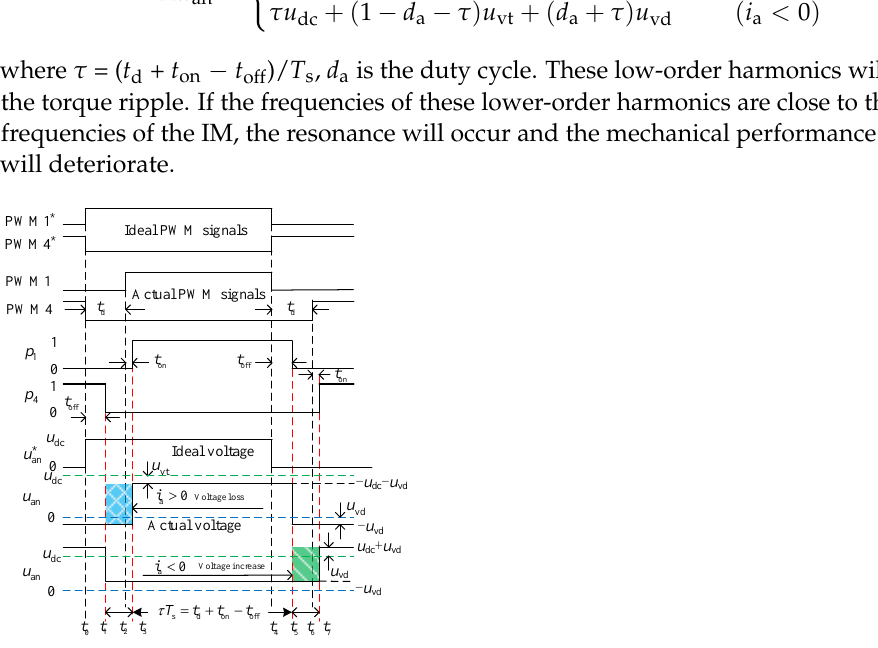
Figure 6. The effect diagram of the deadtime and voltage drops of the switching tube.